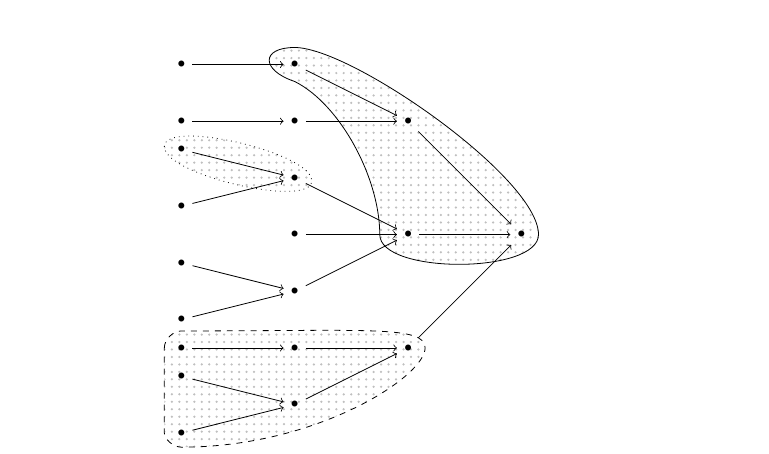
Figure 2: Example of a tree S ∈ S T , along with an identification of three subtrees. The subtree with a dashed line is a leaf subtree, and the one with a solid line is a final subtree. The subtree with a dotted line is neither leaf nor